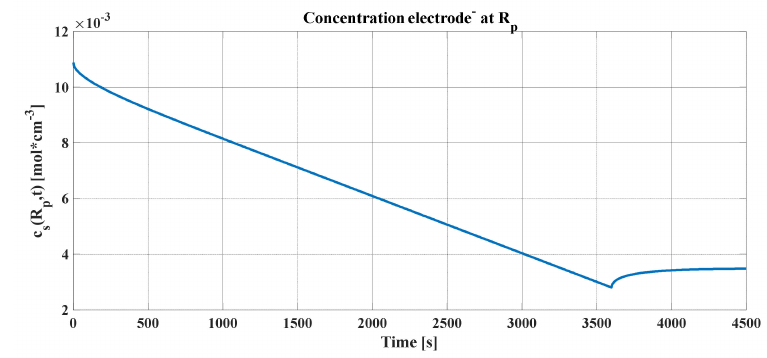
Figure 8. Concentration (Li + ) on the surface of the negative electrode (SPM).